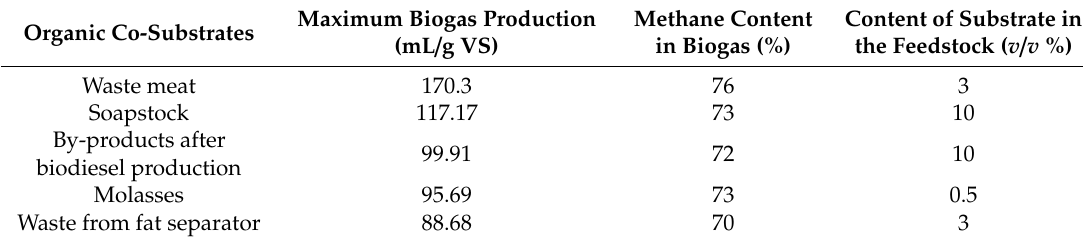
Table 2. The maximum biogas production and methane content in biogas for di ff erent organic co-substrates